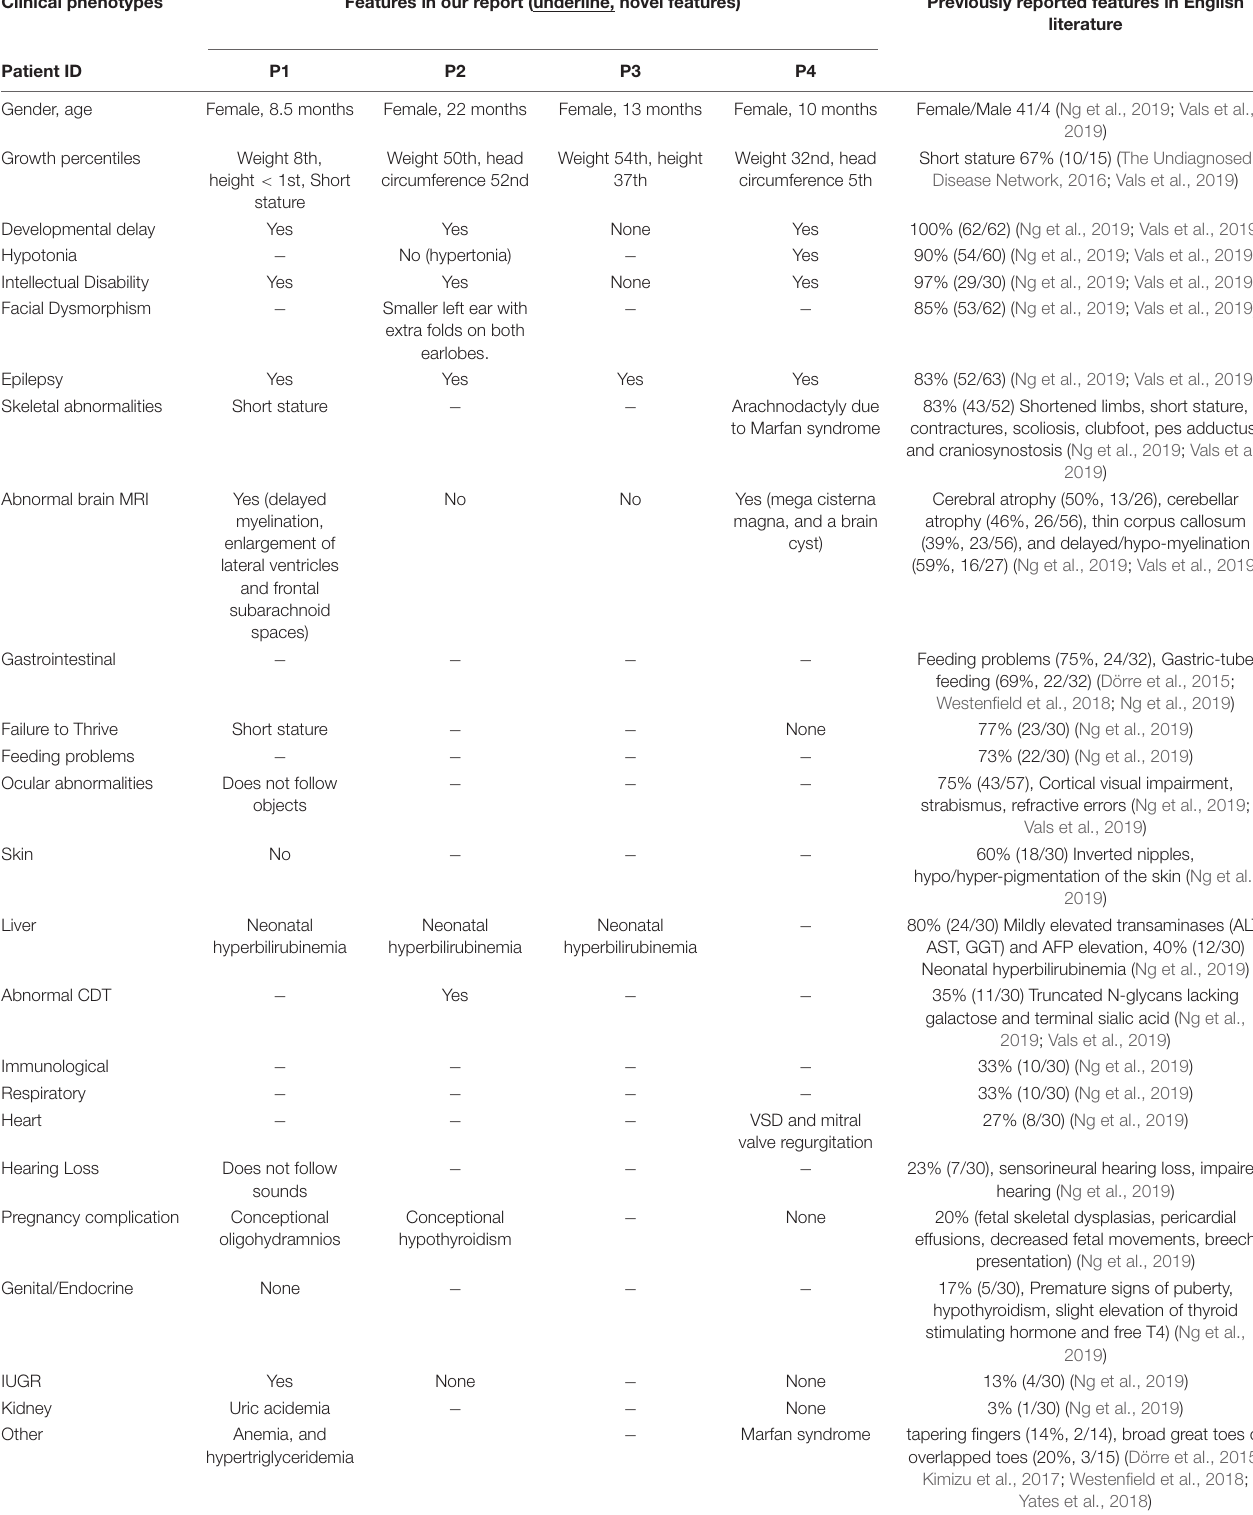
TABLE 1 | Clinical characteristics of patients from our cohort and previous